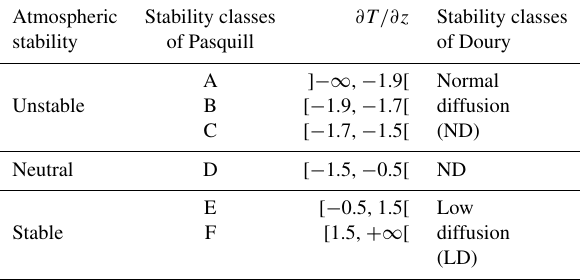
Table A2. Pasquill classes according to method of temperature gra- dient, and correspondence with the classes of